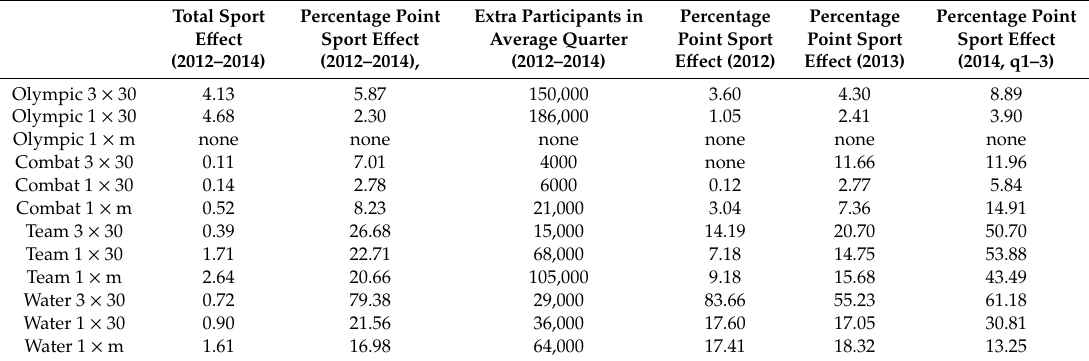
Table 2. Sport legacy e ff ect by Olympic sport